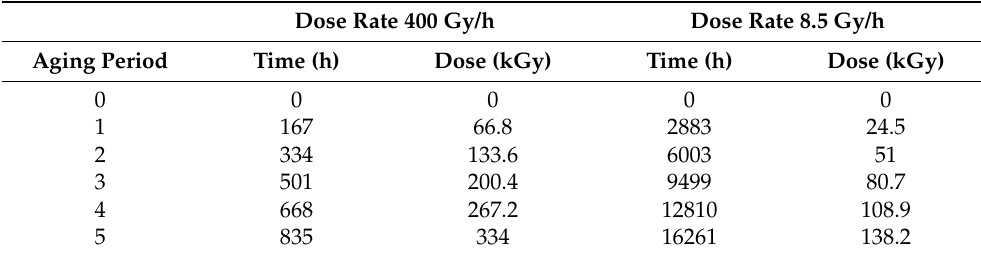
Table 1. Radiation-aging